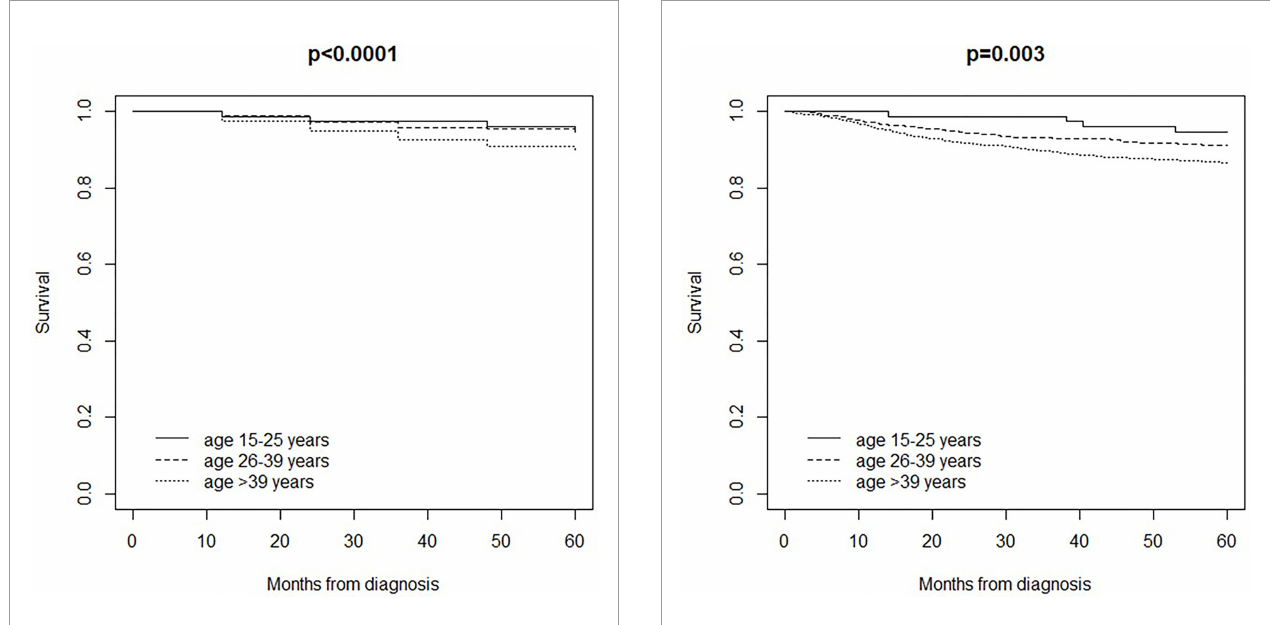
FIGURE 2 | Disease-free survival in 2,734 patients (18 patients were lost to follow-up) aged ≥ 15 years and living in the Veneto Region who were diagnosed and/or treated for Melanoma between 1998-2014 at the Veneto Institute of Oncology and at the University Hospital of Padua (Italy): comparison between age classes (15-25 years, 26-39 years, 40 years or